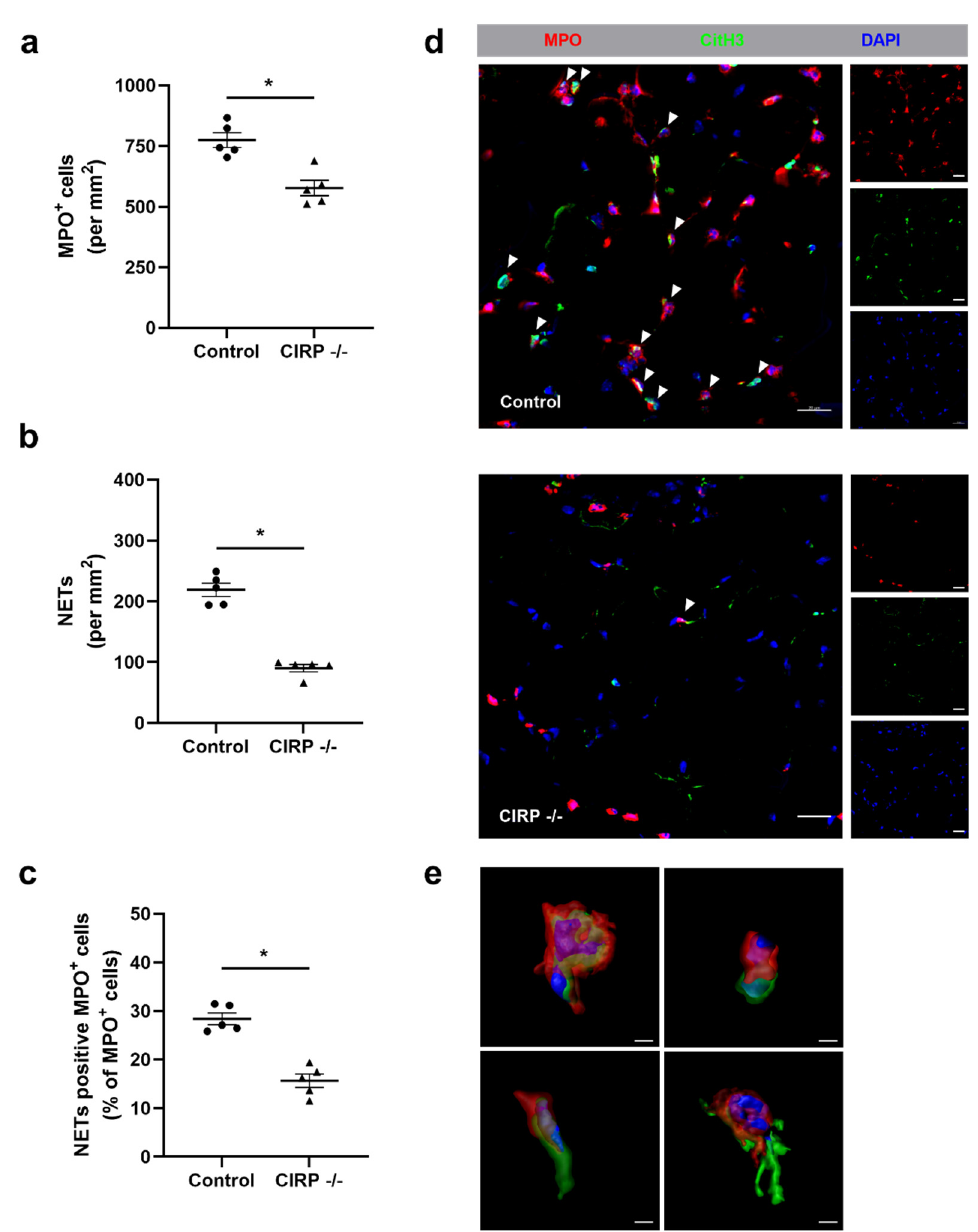
Figure 5. Absence of Cold-inducible RNA-binding protein (CIRP) interferes with neutrophil recruitment and neutrophil extracellular trap (NET) formation in ischemic muscle tissue. The scatter plots display the number of ( a ) MPO + (myeloper- oxidase, marker for neutrophils) cells, ( b ) NETs (both per mm 2 ), and ( c ) NET positive MPO + cells per total MPO + cells in ischemic gastrocnemius muscles isolated from control and -/- mice 1 day after femoral artery ligation (FAL). Data are means ± S.E.M., n = 5 per group. * p < 0.05 (CIRP -/- vs. control) by unpaired, two-sided student’s t-test. ( d ) Representative immunofluorescence staining of ischemic gastrocnemius muscle slices of CIRP wildtype control (above) and CIRP -/- (below) mice 1 day after FAL. Images display single and merged channels of neutrophils (MPO + ) and NETs (MPO + /CitH3 + ) (citrullinated histone 3) (indicated by white arrowheads) labeled with anti-MPO (red), anti-CitH3 (green), and DAPI (nucleic acid, blue). Scale bars 20 µ m. ( e ) Representative immunofluorescence image of detailed 3D rendering images showing NET formation in different stages. Scale bars 3 µ